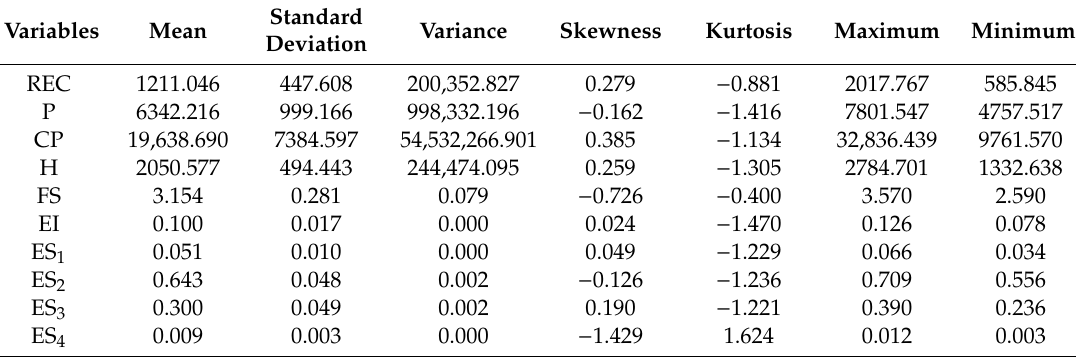
Table A1. Descriptive statistics of the main variables in urban